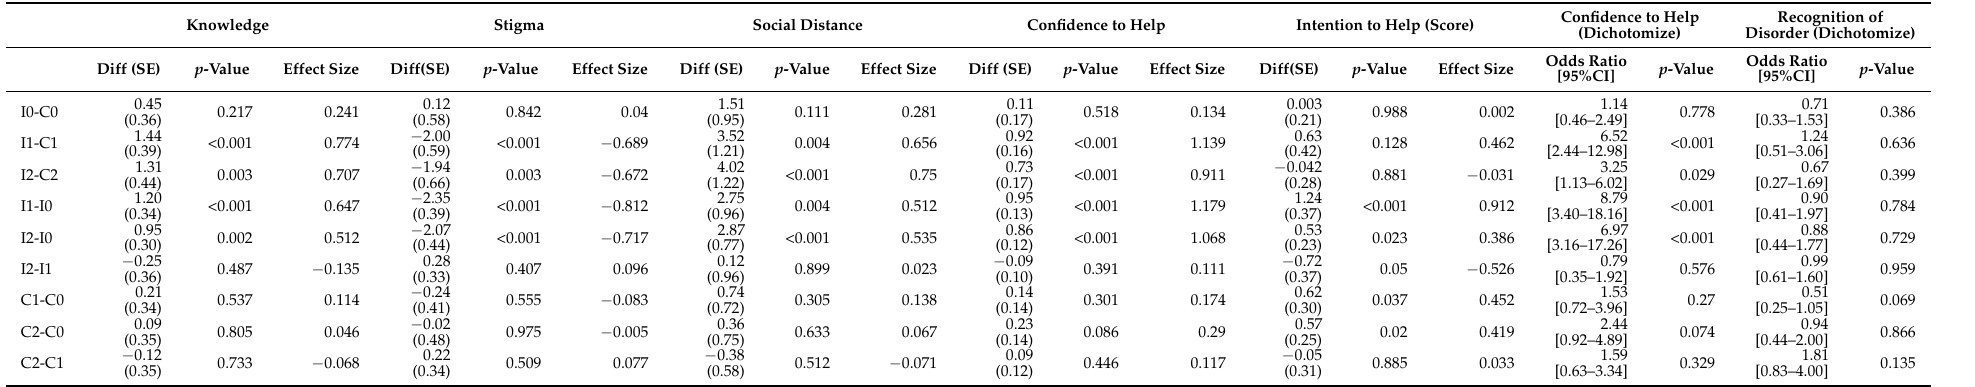
Table 3. Multiple comparisons using Generalized Equation Estimation